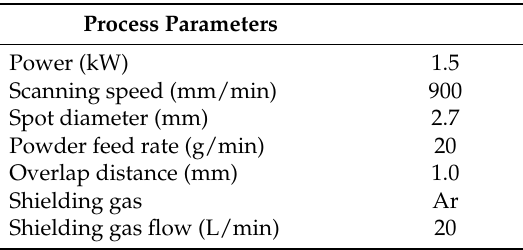
Table 4. Process parameters for producing crack-free